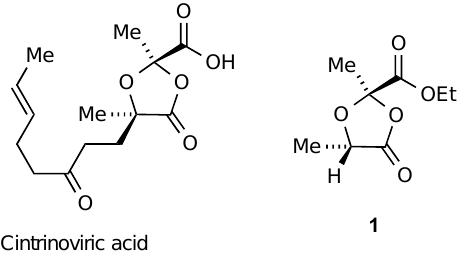
Figure 1. Citrinoviric acid and the target synthetic intermediate.